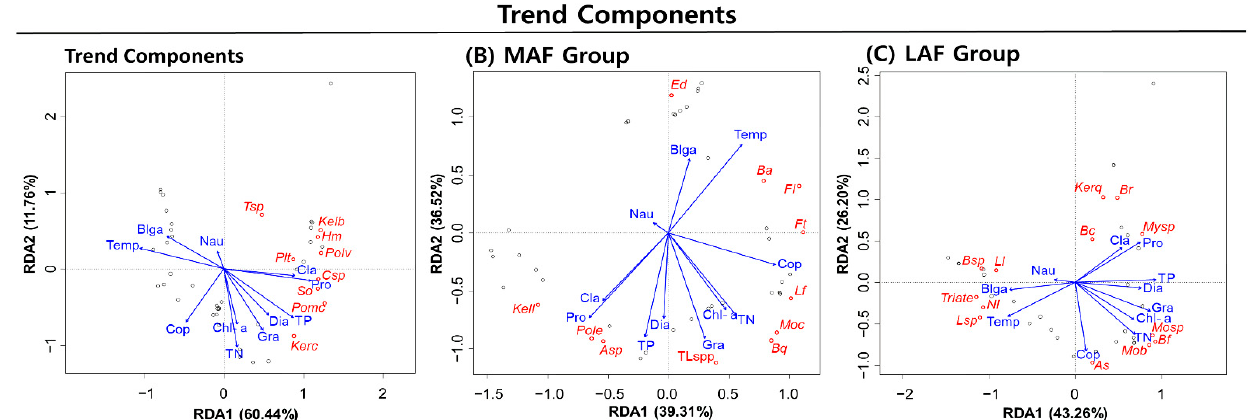
Figure 7. Redundancy analysis of the trend components (derived from the time series of the abun- dance estimates of three rotifer groups) and environmental factors. ( A ) High abundance and fre- quency rotifers group, ( B ) Middle abundance and frequency rotifers group, ( C ) Low abundance and frequency rotifers group.